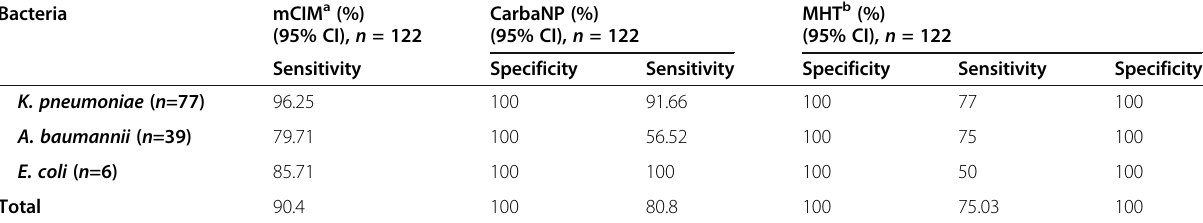
Table 2 Performance of three phenotypic methods compared with the molecular detection of carbapenemase-producing isolates in the study